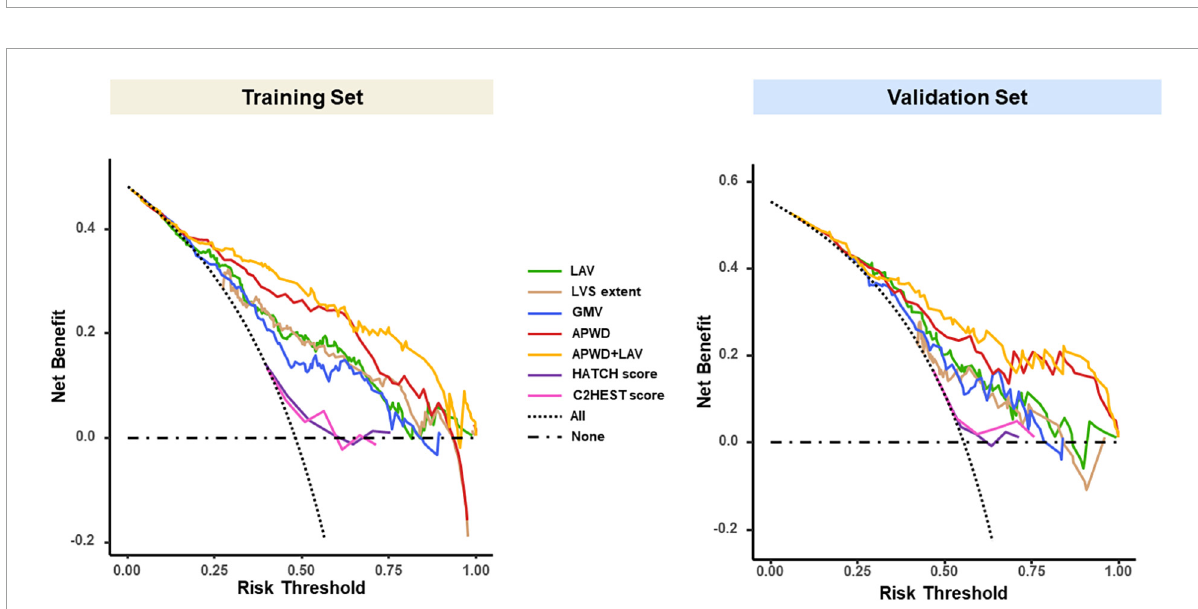
FIGURE7 Decision curve analysis (DCA) of each model in training (left) and validation (right) sets. The vertical (Y) axis measured the net benefit, the horizontal (X) axis represents the range of potential risk threshold for persistent AF from diagnostic models. The “All” dashed dark line represented the assumption that all patient has persistent AF. The “None” dark dashed line represented the assumption that no patient has persistent AF. The clinical usefulness of each model across the range of risk thresholds is illustrated in different colors: green for LAV, brown for LVS extent, blue for GMV, red for APWD, yellow for APWD + LAV. The HATCH score and C2HEST score were presented in purple and pink curves, respectively. The model which positions closer to the right upper corner indicates better clinical usefulness. LAV, left atrial volume; LVS, low voltage substrate; GMV, global mean voltage; APWD, duration of the amplified digital